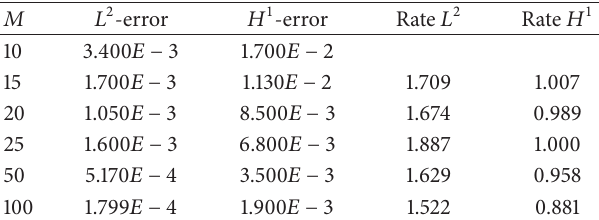
Table 2: SFD method error in both 𝐿 2 and 𝐻 1